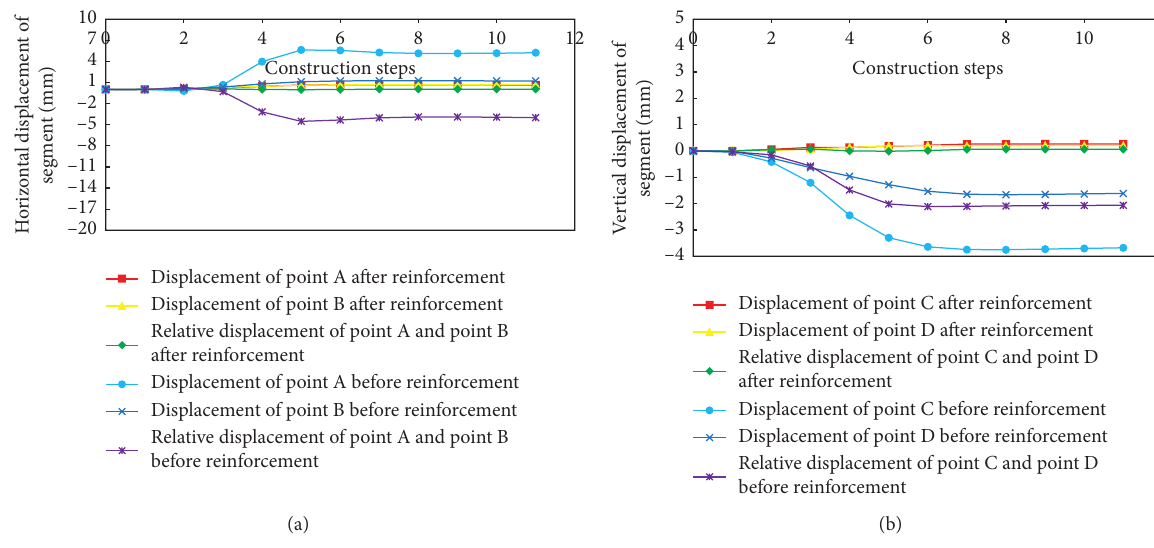
Figure 17: Deformation curve of the right line 132nd ring segment caused by left shield excavation before and after reinforcement. (a) Horizontal displacement curves of points A and B before and after reinforcement. (b) Vertical displacement curve of points C and D before and after